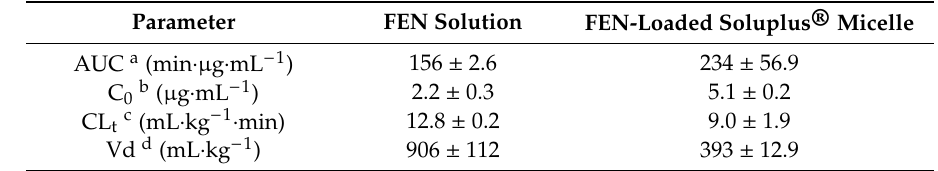
Table 2. Pharmacokinetic parameters of fenbendazole (FEN) after intravenous injection of FEN-loaded Soluplus ® micelles and FEN dissolved in 25% Cremophor EL ® / EtOH solution.